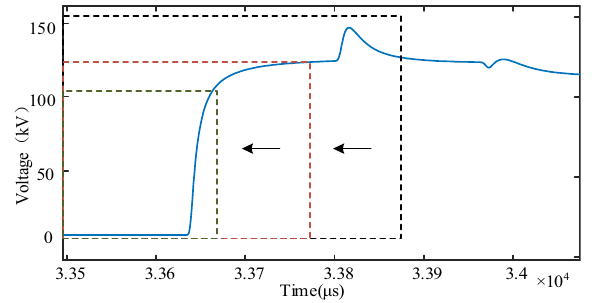
Figure 3. S-transform time window movement diagram.